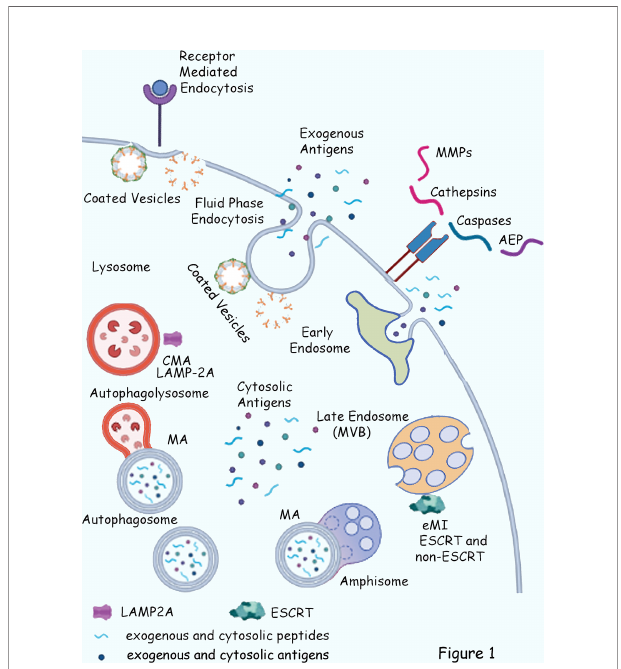
FIGURE 1 | Schematic of the cytosolic and exogenous pathways for antigen delivery to MHC II compartments. Exogenous antigens are acquired through fl uid phase endocytosis and receptor-mediated endocytosis. Cytosolic proteins enter MHC II compartments through Macroautophagy (MA), upon fusion of the Autophagosomes with Lysosomes (Autophagolysosome) or with Late Endosomes (Amphisome); Endosomal Microautophagy (eMI, ESCRT-dependent and independent), and LAMP2A-mediated chaperone-mediated autophagy (CMA). Additional antigen-acquisition routes include preprocessed cytosolic proteasome- generated peptides, as well as acquisition of extracellular peptides present in biological fl uids loaded on plasma membrane and early-endosomes recycling MHC-II molecules. As such, MHC-II-eluted self-peptides derived from a variety of processing pathways including Cathepsins, Caspases and other endopeptidase such as asparagine endopeptidase (AEP), and matrix metalloproteases (MMPs), among many